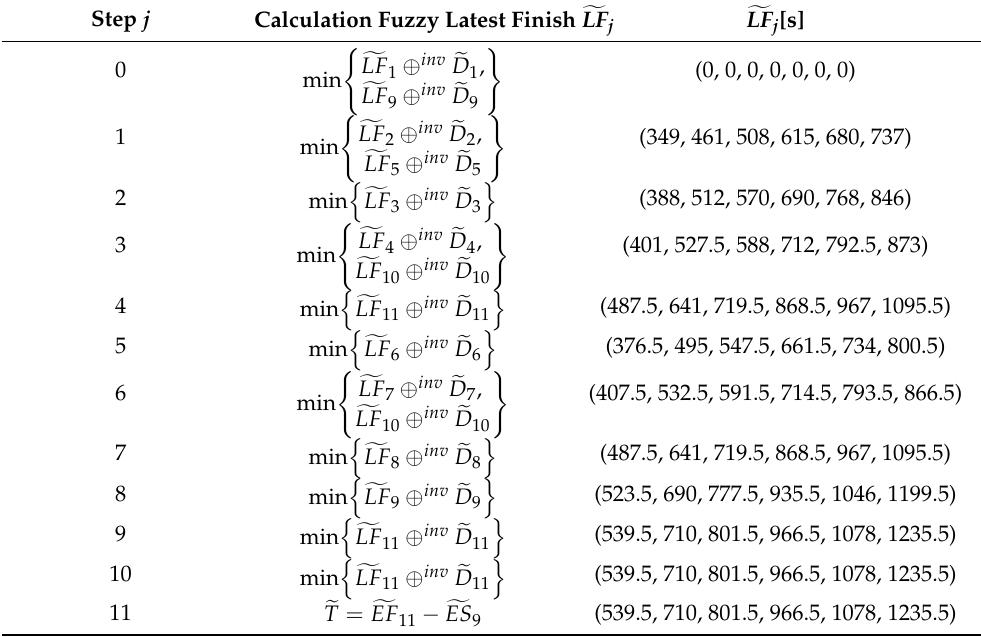
Table A3. Fuzzy latest finish times ( (cid:102) LF j ) of disassembling